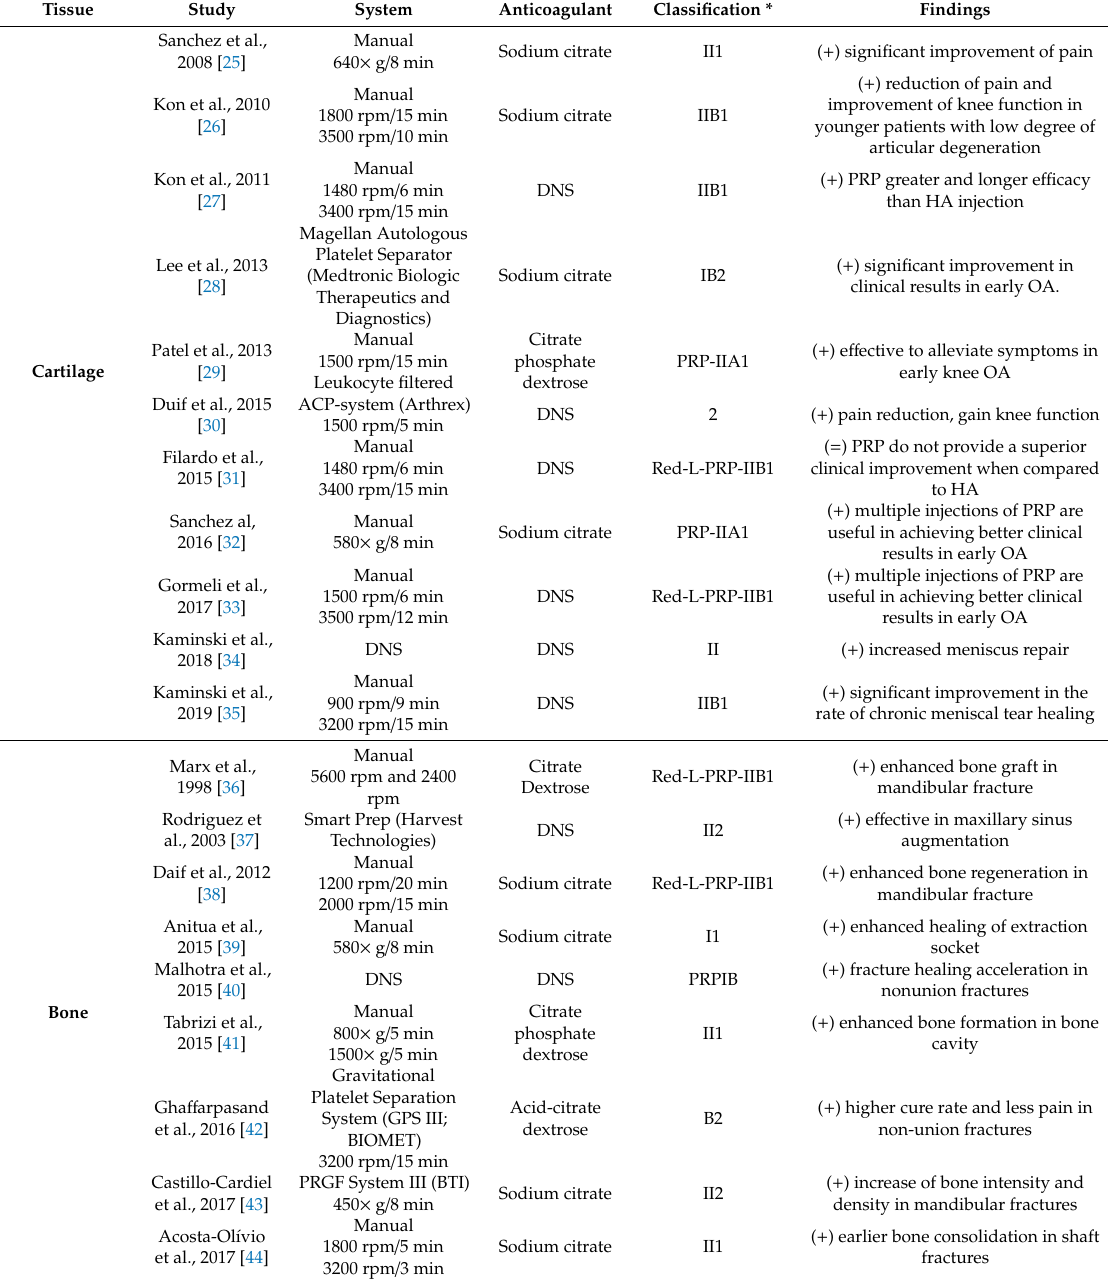
Table 1. Main findings of the use of platelet-rich plasma (PRP) in clinical trials according to the tissue